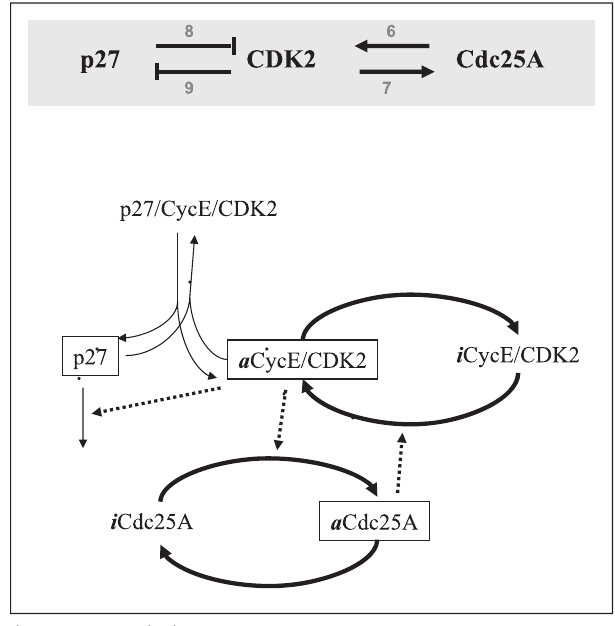
Figure 2. A Sharp Switch Is Expected from the Mutual-Activation and Mutual-Inhibition Topology Involving CDK2 Also shown are the known detailed mechanistic steps corresponding to the qNET shown in the upper panel (shaded grey). ‘‘ a ’’ refers to active, and ‘‘ i ’’ to inactive. Note that the network in the lower figure uses the chemist’s convention of representing reaction steps; also, dashed arrows mean that the protein where the arrow originates from induces or catalyzes the reaction step that the arrow points